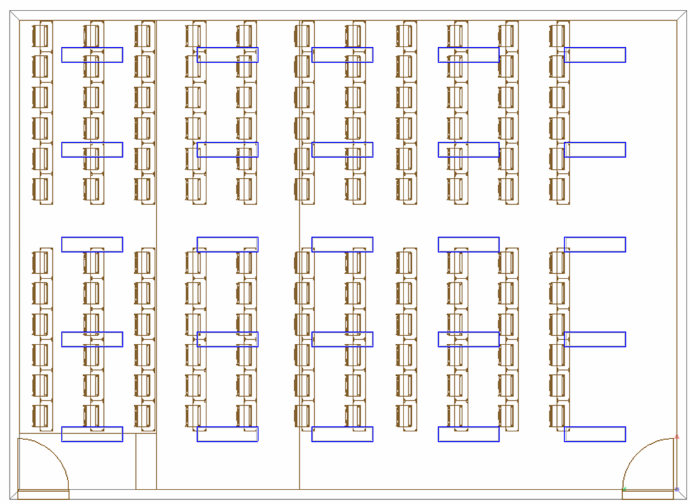
Figure 9. Layout of TR-214